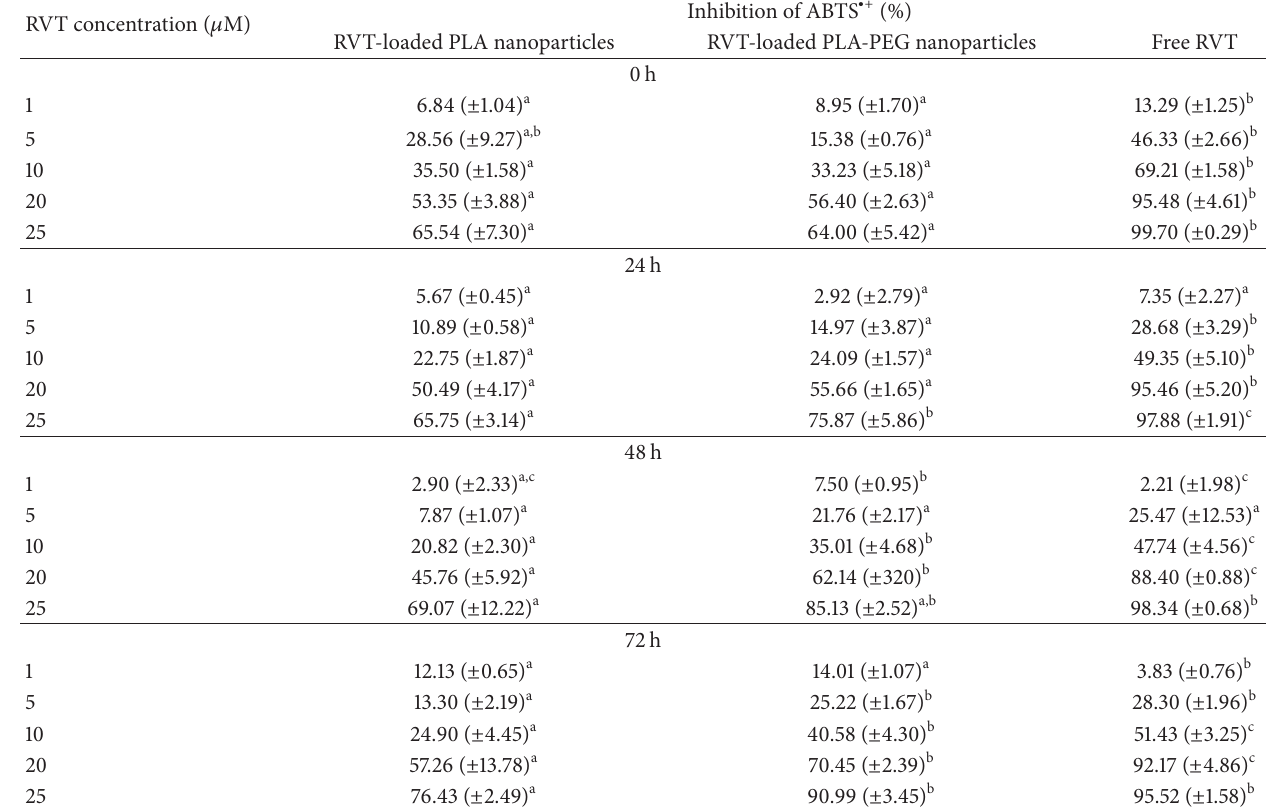
Table 4: Percentage of inhibition of the radical ABTS ∙ + from free and nanoencapsulated RVT in concentrations of 1, 5, 10, 20, and 25 𝜇 M for 0, 24, 48, and 72 h.